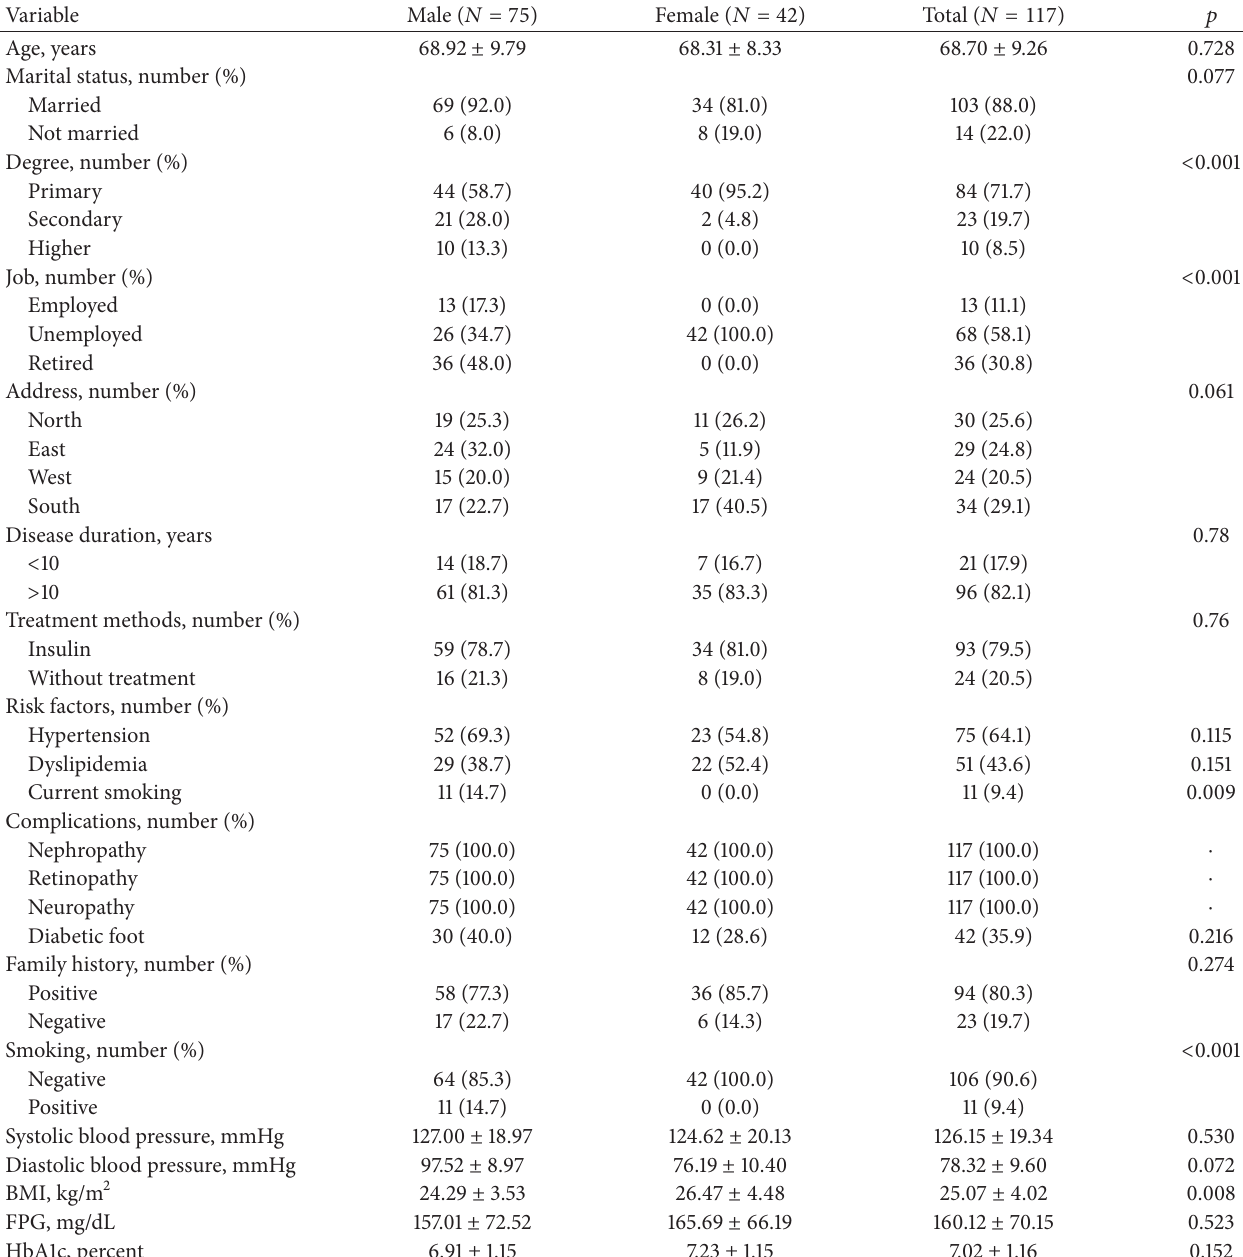
Table 1: Description of baseline characteristics of